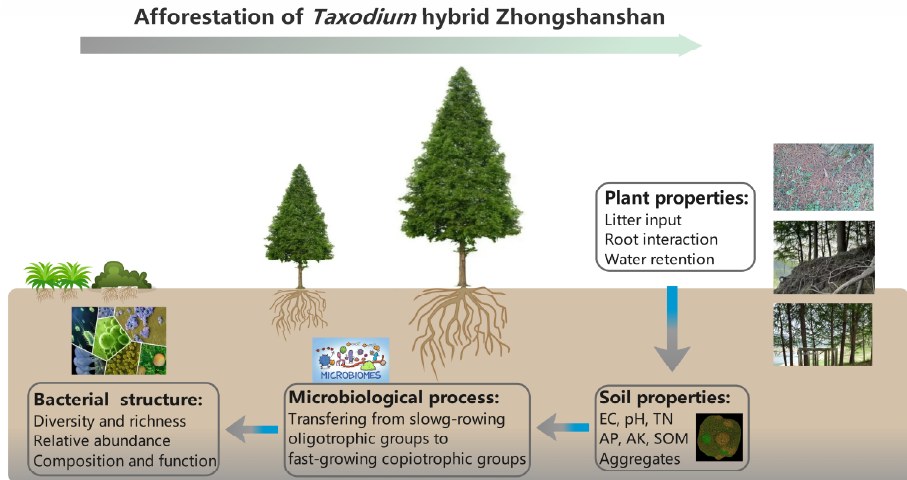
Figure 7. Afforestation of Taxodium hybrid Zhongshanshan influences soil bacterial community structure by altering soil properties.